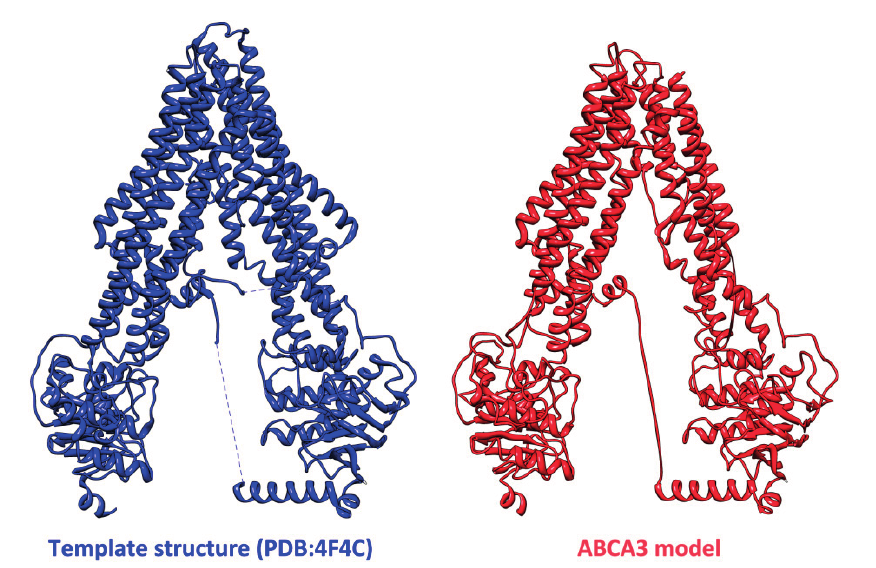
Figure 4. The template structure and the ABCA3 model obtained by